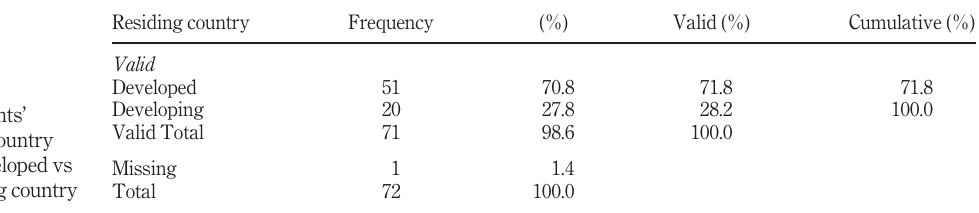
developing country